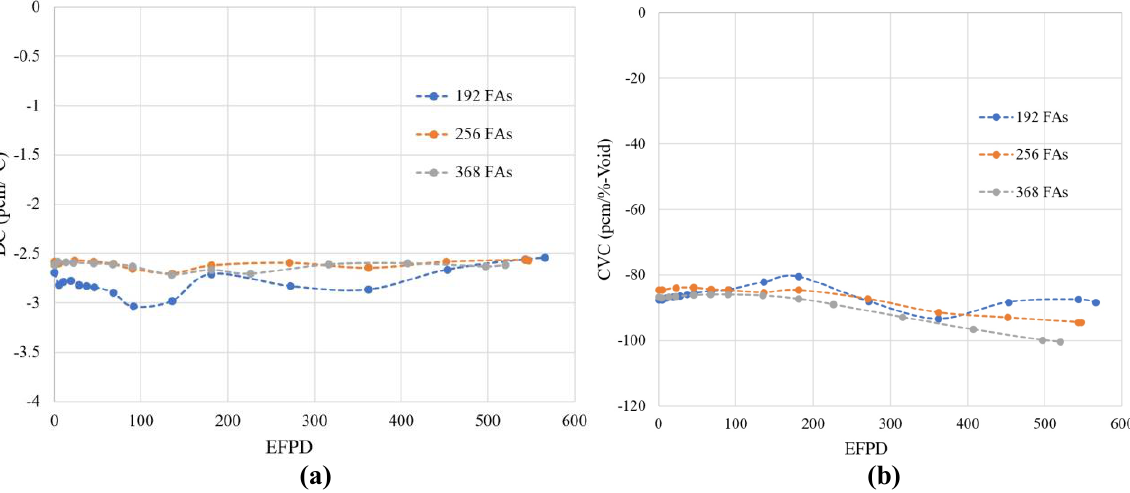
Figure 7. Reactivity Feedbacks Comparison for The Studied Geometries with 3-Batch Arrangement: (a) Doppler Coefficient; (b) Coolant Void